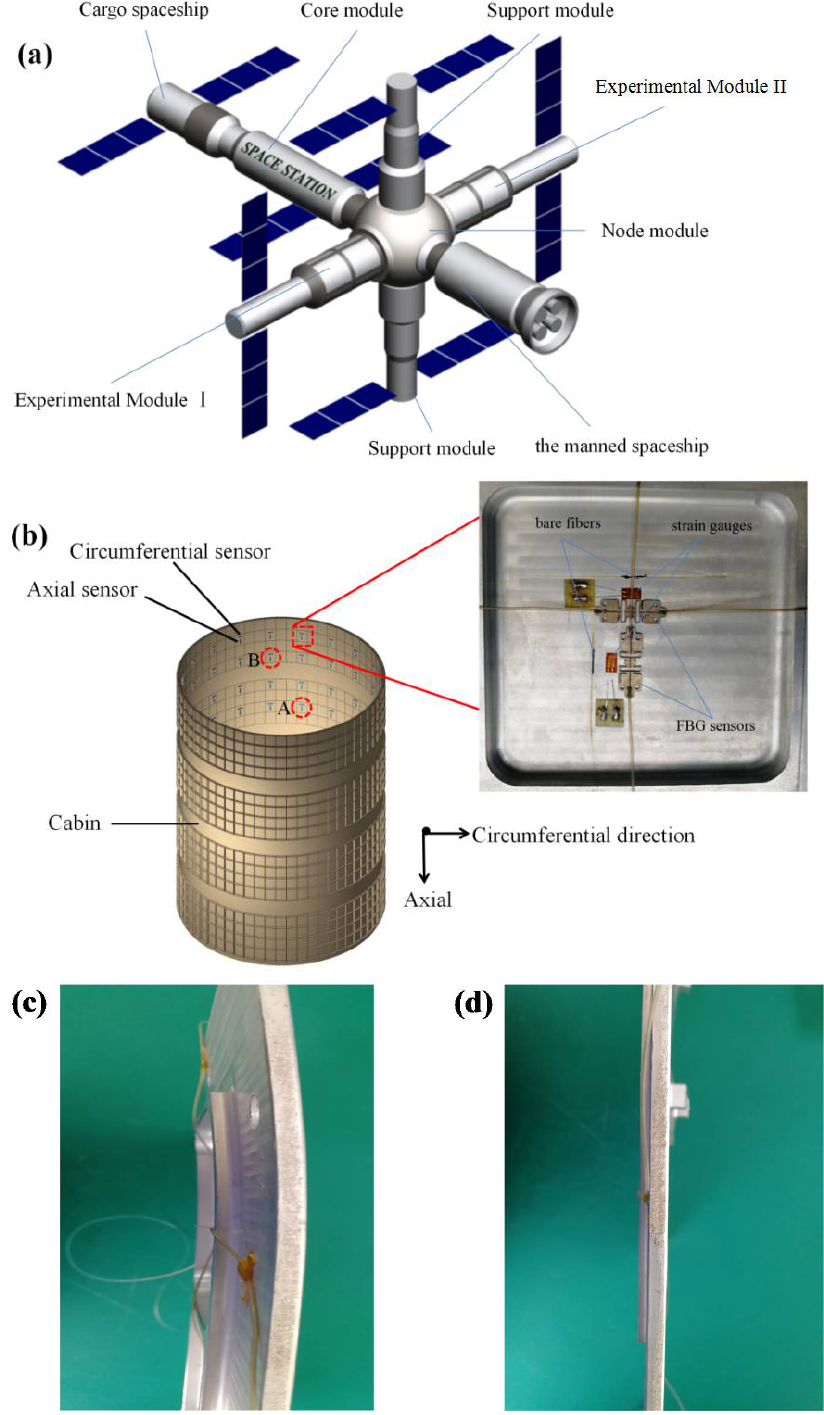
Figure 2. Schematic of the space station ( a ) and installation of FBG sensors in the cabin ( b ). Top view of the bulkhead ( c ) and right view of the bulkhead ( d ).